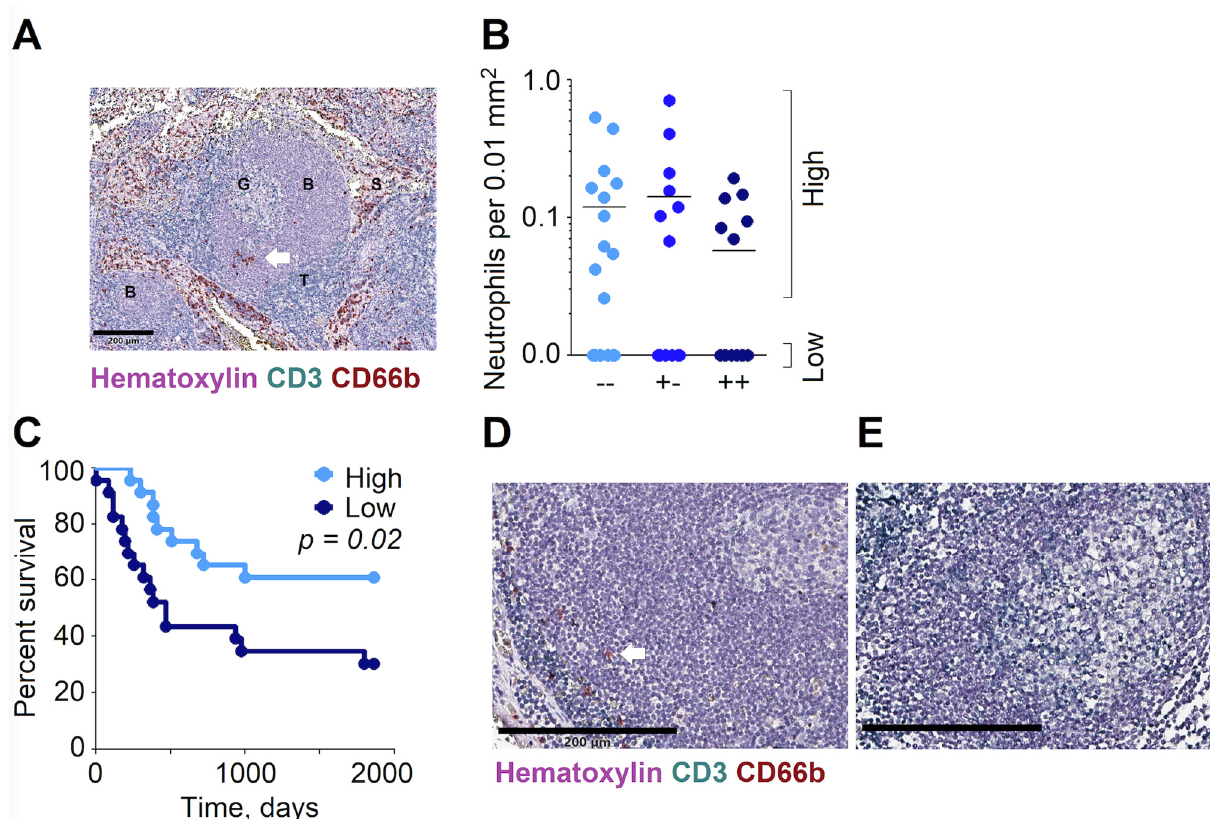
Figure 5. The high abundance of neutrophils in B cell follicles of RLNs significantly improves the overall survival of HNC patients. RLNs ( n = 47) of patients with HNC were embedded in paraffin; the density of CD66b + cells in B cell follicles was quantified in 3–5 follicles per image and correlated with the 5-year survival rate of the patients. ( A ) Immunohistochemistry of human RLNs. B: B zones, S: sinuses, T: T zones, G: germinal center. Red: CD66b+ neutrophils, violet/purple: B cells, green: CD3+ T cells. Exemplified figure in 200 µm scale bar. ( B ) Neutrophil counts in non-metastatic (“met − − ” (cyan) and “met+ − ” (light blue)) and metastatic LNs (“met++” (dark blue)). ( C ) Overall survival of HNC patients' is increased in high (light blue) neutrophil count when compared to low (dark blue) neutrophil count. ( D , E ) Immunohistochemistry of human RLNs. Exemplified images of the high and low infiltration of B cell follicles by neutrophils. Red: CD66b+ neutrophils, violet/purple: B cells, green: CD3+ T cells. Scale bar, 200 µm ( D ) and 100 µm ( E ). Kaplan–Meier curves for the survival function were compared via a log-rank test.